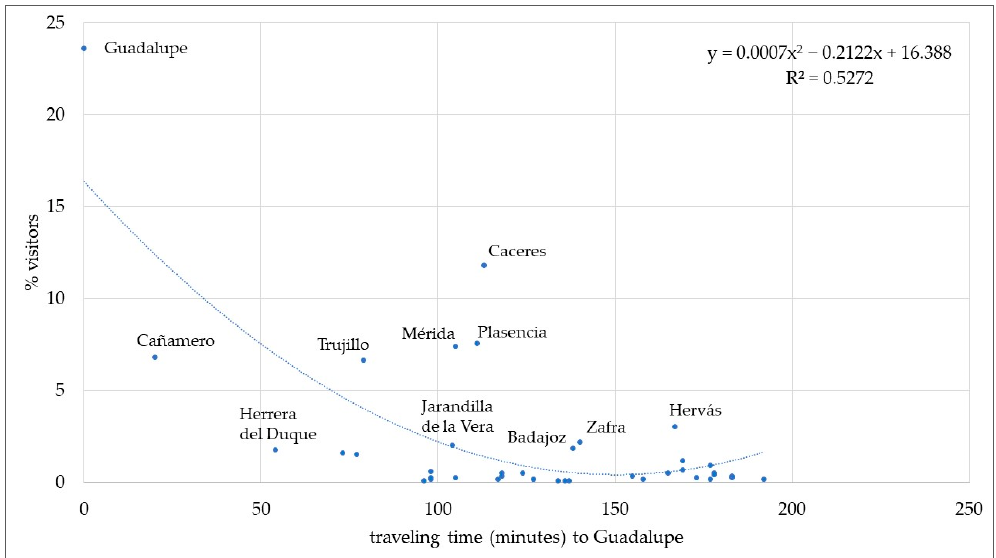
Geosciences 2019 , 9 , x FOR PEER REVIEW Figure 4. Journey times from the overnight stay locations to the geopark. Figure 4. Journey times from the overnight stay locations to the geopark.